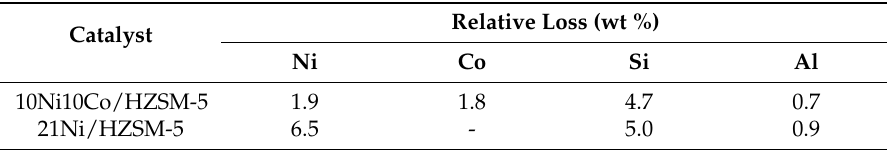
Table 6. Loss of metal atoms in supported HZSM-5 catalysts after 24 h on-stream based on inductively coupled plasma-optical emission spectroscopy (ICP-OES) and atomic adsorption spectroscopy (AAS) results.